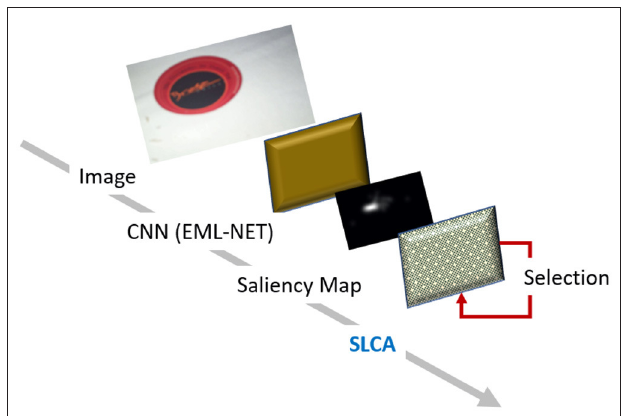
FIGURE 1 | SLCA model architecture. We use EML-Net to produce the salience maps, which are then used as input to our